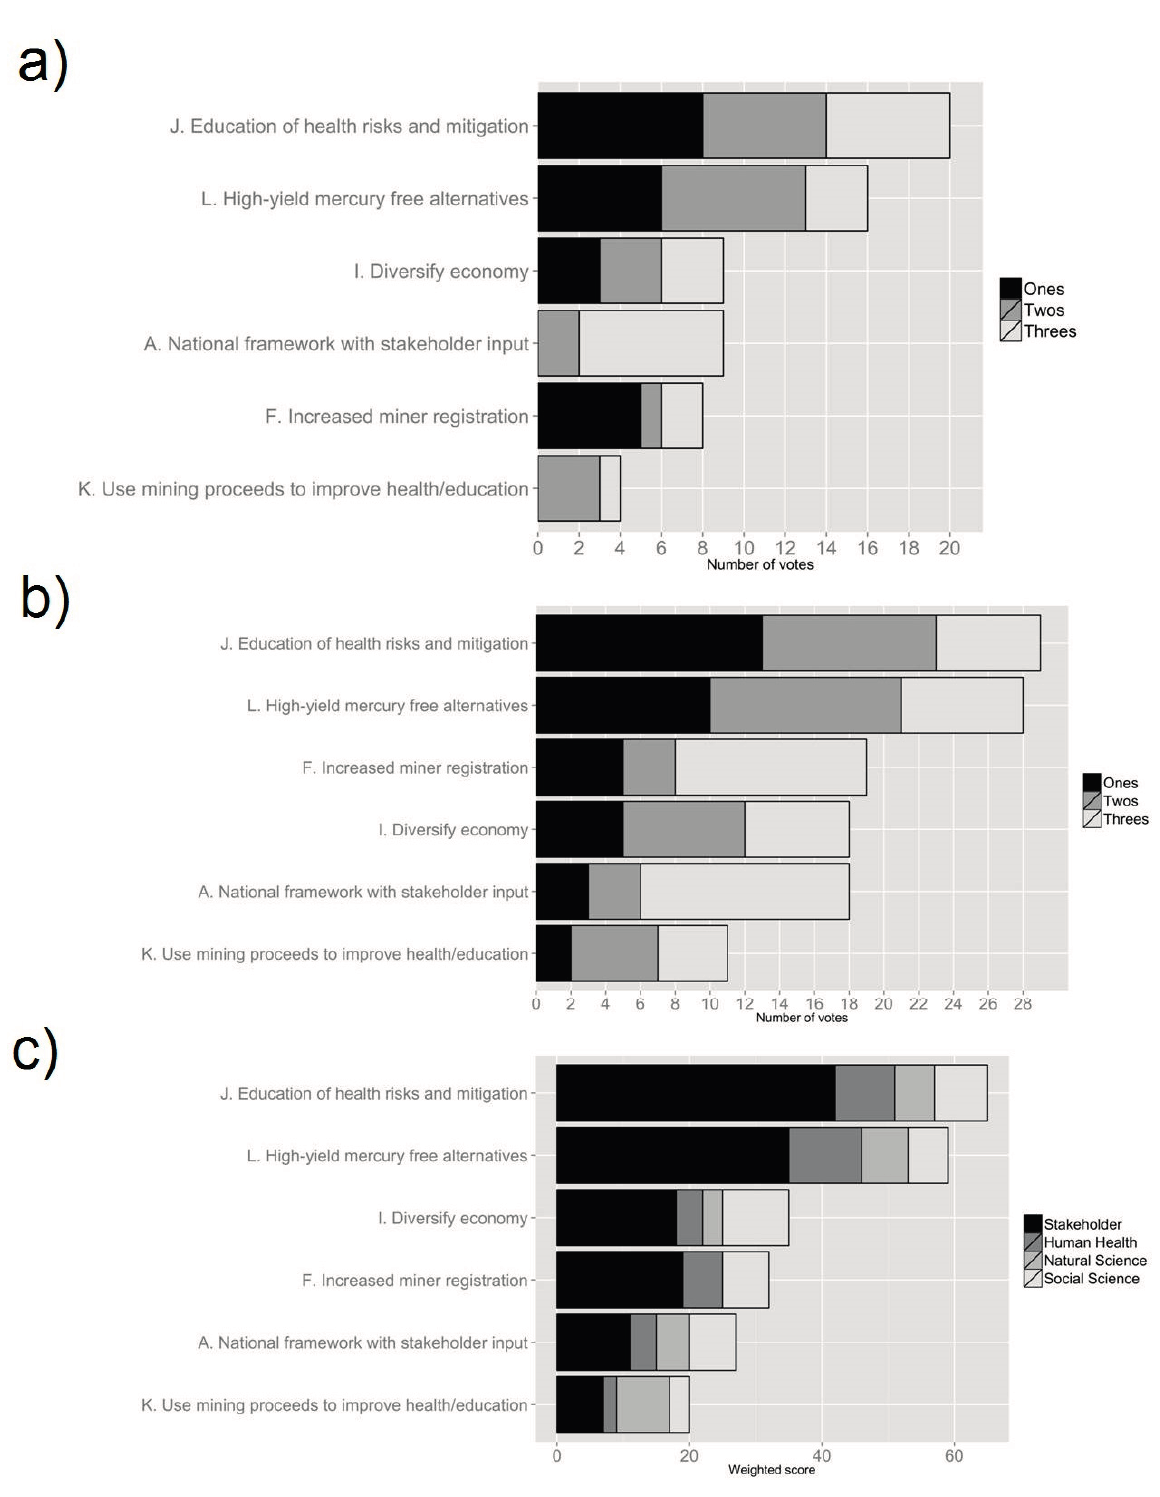
Figure 6. Results from sticky note exercise used to prioritize response options, conducted among academics (n = 27) in April 2014 and among stakeholders (n = 22) in April 2015. ( a ) Number of votes for each option; ( b ) Combined sticky note scores for all groups (academics and stakeholders); ( c ) Weighted scores for each option, grouped by